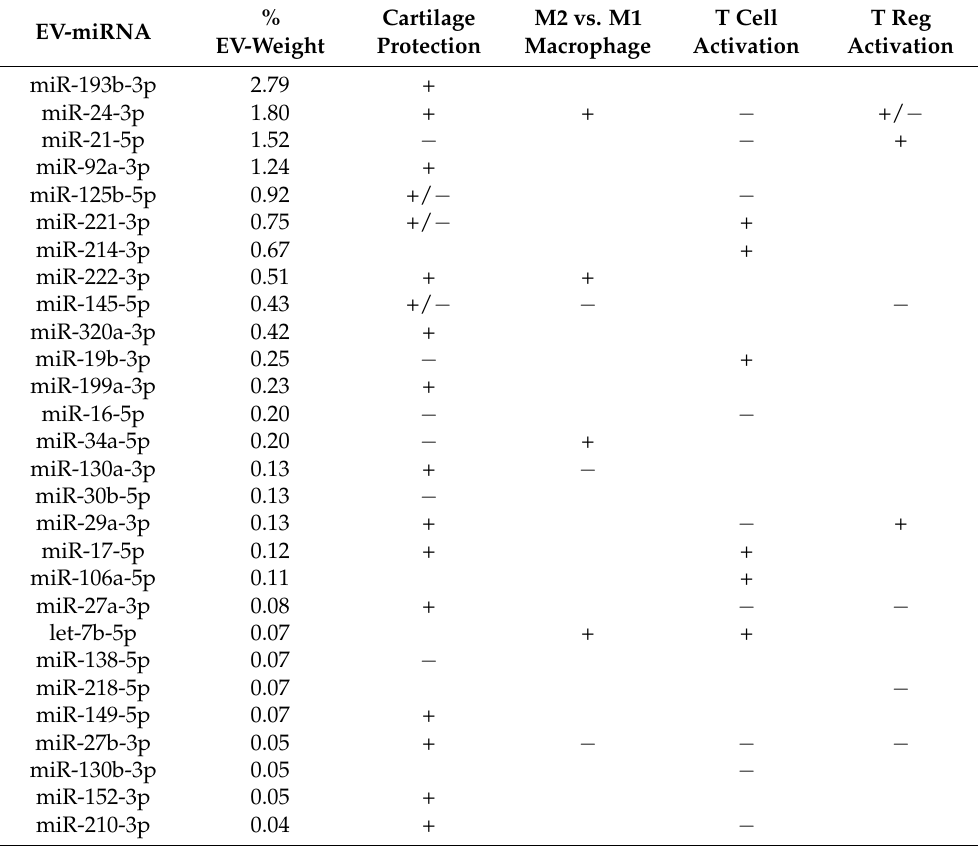
Table 2. EV-miRNAs involved in OA-related cell types and